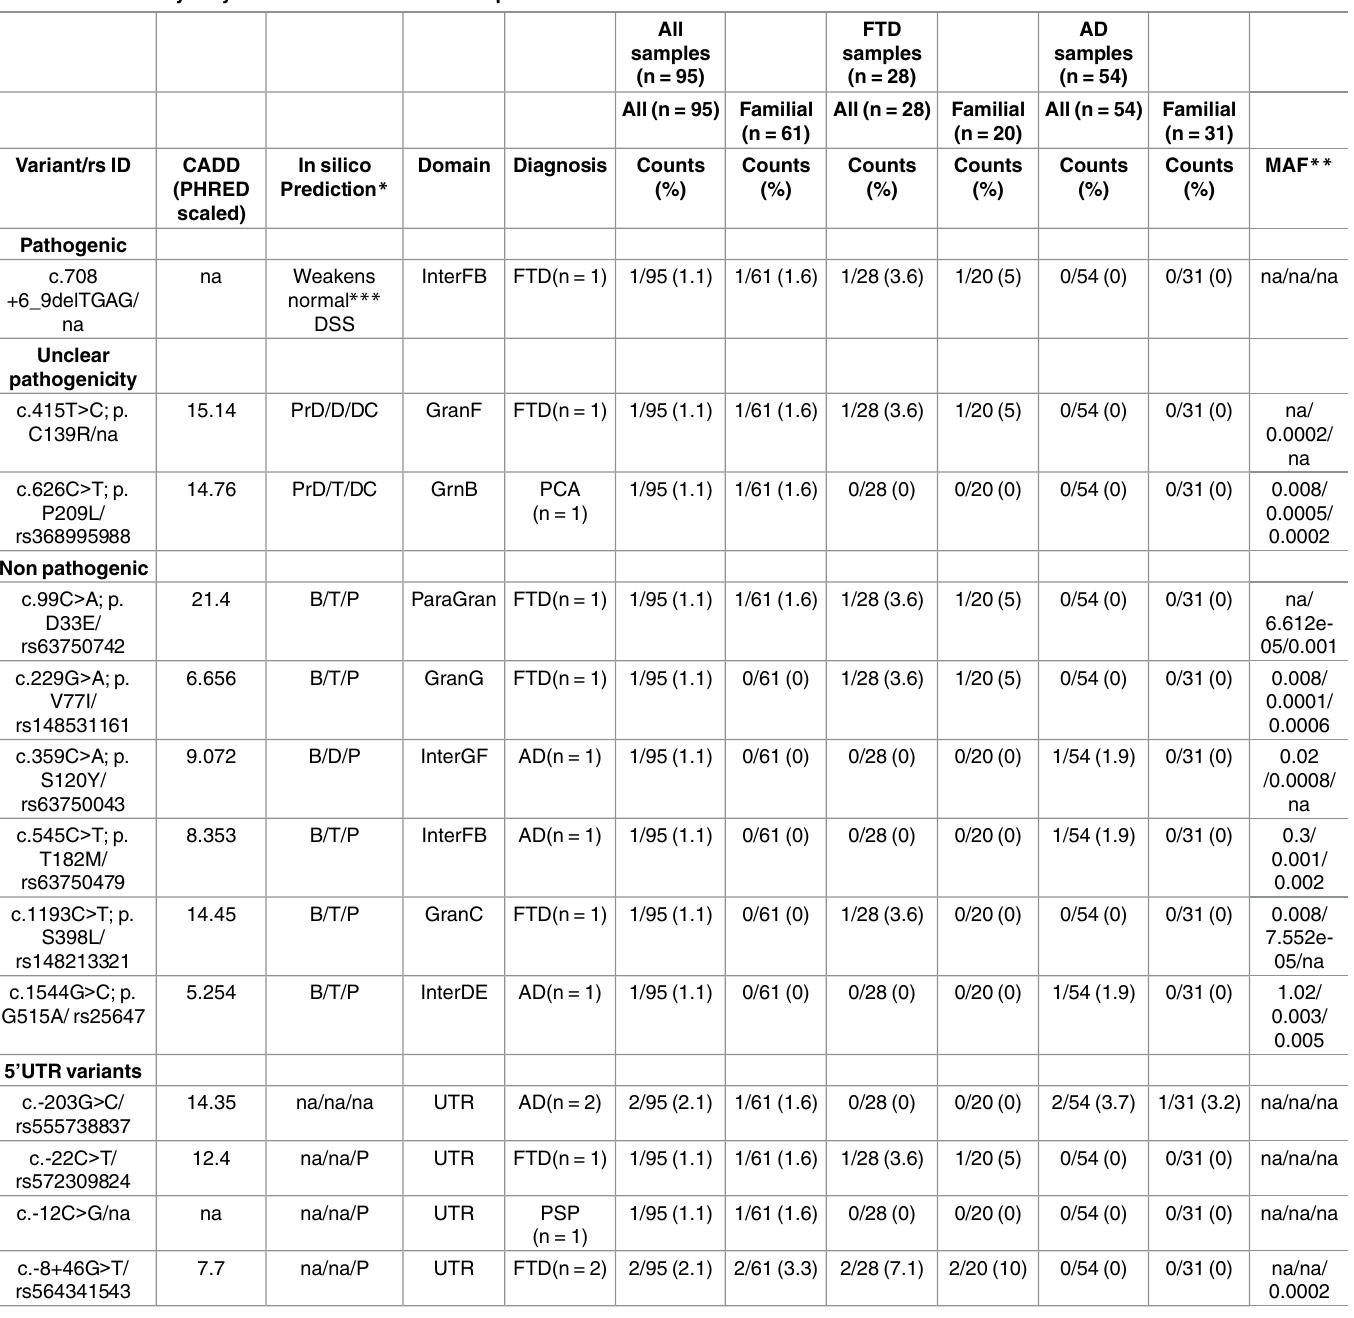
Table 3. GRN nonsynonymous variantsand allelefrequencies.